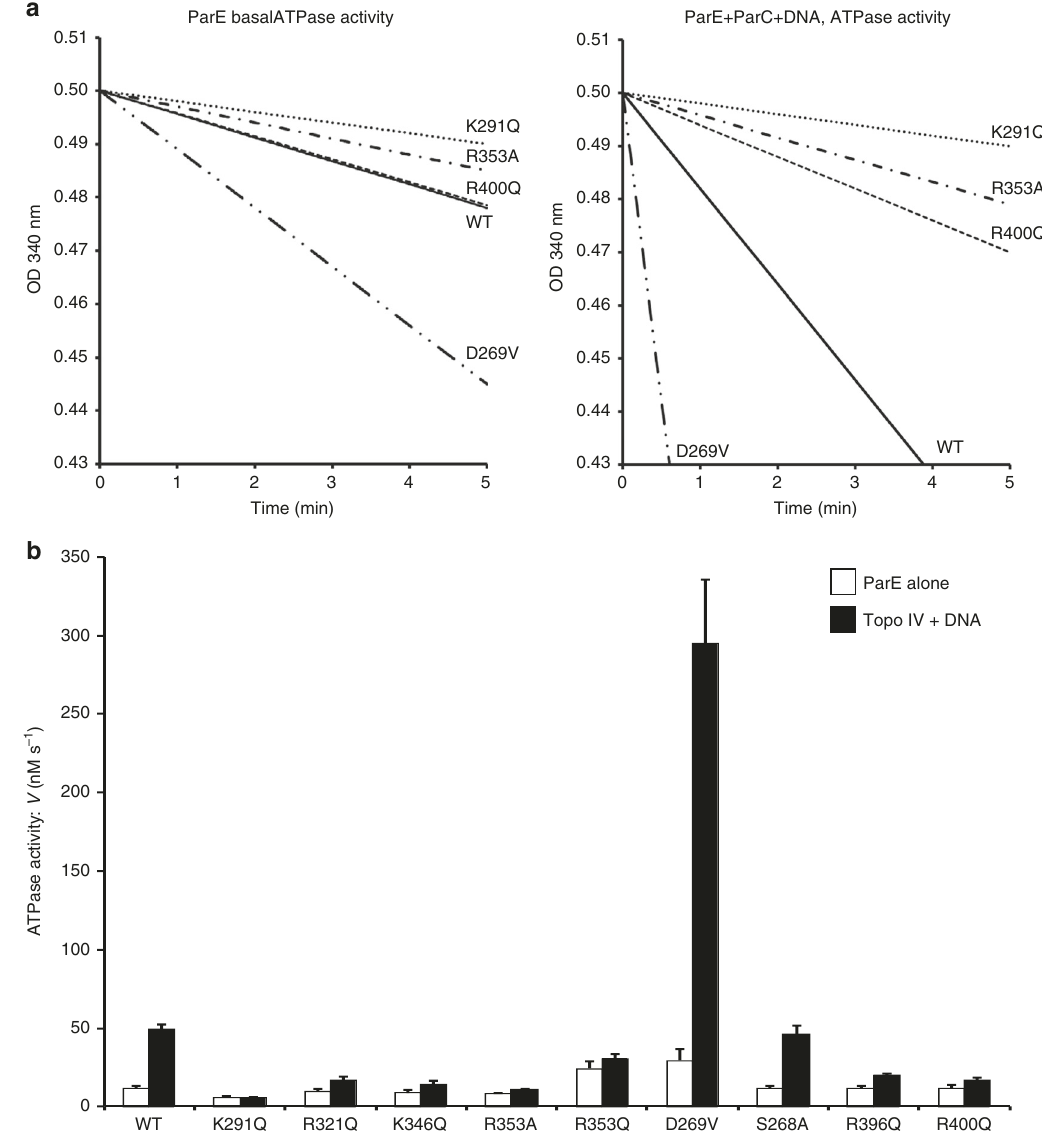
Fig. 6 Measuring the ATPase activity of ParE proteins. a Comparison of basal ATPase rates for wild-type (WT) and representative ParE cavity mutants and stimulation by ParC and DNA. A coupled enzyme assay was used wherein ATPase activity was measured through the change in NADH absorbance at 340 nm 34,35 . The reaction mix contained topo IV decatenation buffer, 2 mM ATP and 100 nM ParE and was incubated at 37 °C in the presence or absence of 130 nM ParC and 10 µ g pBR322 ( fi nal volume of 500 µ l). b Bar chart showing the ATPase activity of WT ParE and various single mutants of ParE observed in the absence and presence of DNA and ParC (to form topo IV). Reactions were carried out in triplicate on separate days. Error bars show the standard error. Inclusion of DNA or ParC alone did not stimulate ParE ATPase activity. The ParE D269V mutant showed strong basal ATPase activity that was greatly enhanced by inclusion of ParC and